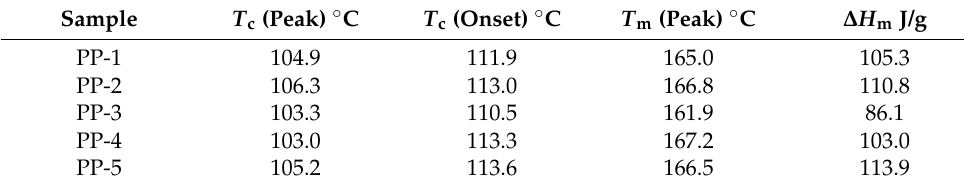
Figure 6. DSC results of the PPs obtained from the POP ‐ based and MgCl 2 ‐ based Z–N catalysts. Table 4. DSC results.